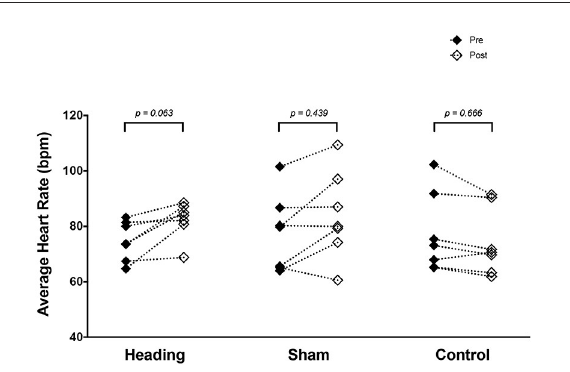
FIGURE2 Heart rate measured before and after exposure to heading, sham, and control conditions across all participants. p -values are for a priori simple effects